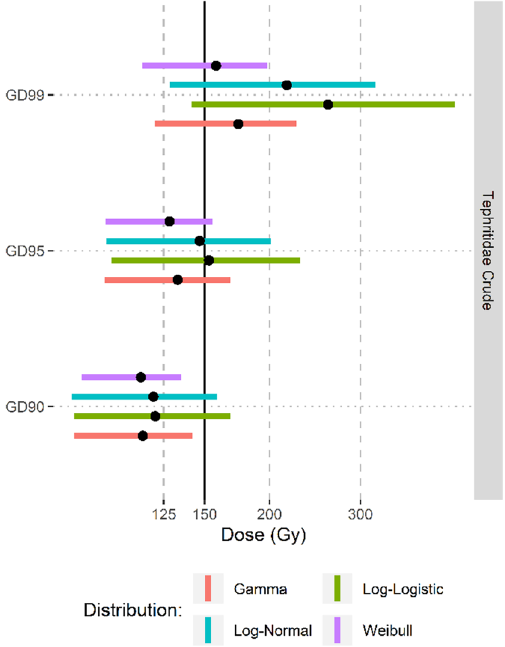
Figure 6. Point estimates and the lower 5% to upper 95% confidence intervals (colored bars) for the generic irradiation dose required to obtain 90, 95 and 99 percent coverage of the family Tephritidae.